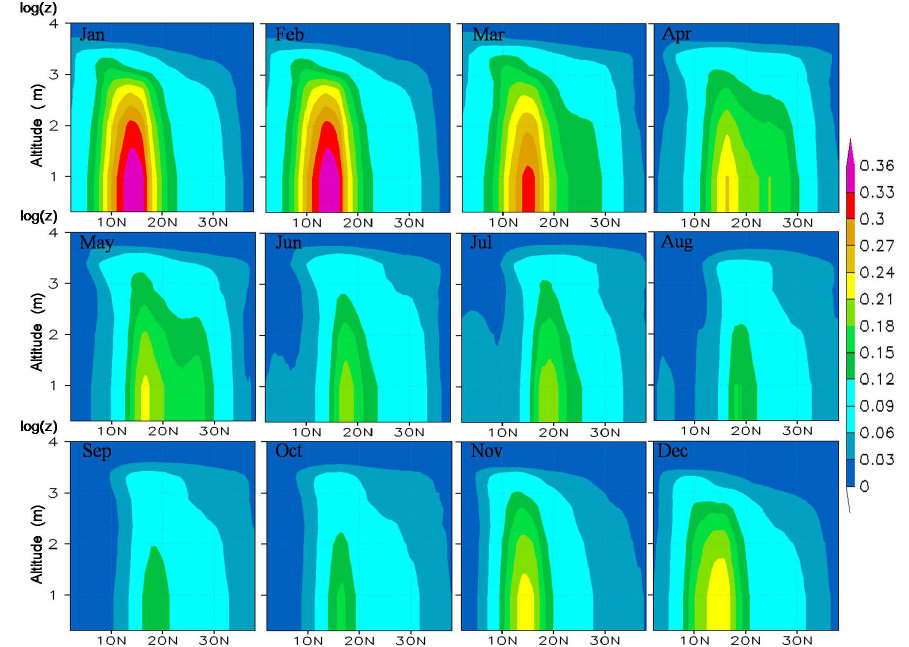
Figure 9. Monthly vertical cross section (30 ◦ W–40 ◦ E) of extinction coefficients (in km − 1 ) simulated by ALADIN averaged from 2006 to 2010 over northern